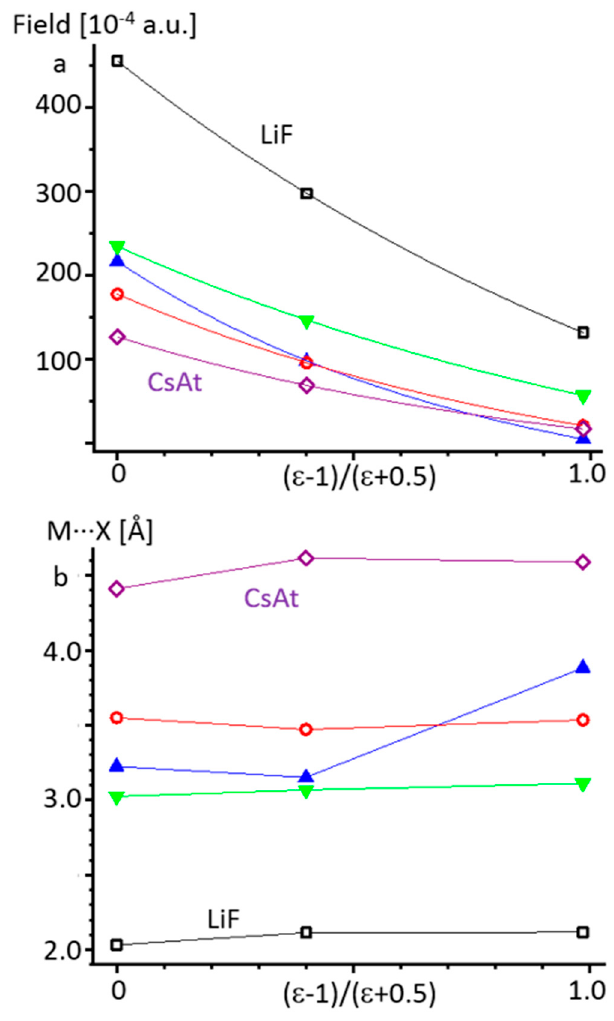
Figure 5. The limiting values of the external electric field ( a ) and the alkali metal ··· halogen distances ( b ) before the dissociation of LiF (empty black squares), KBr (empty red circles), CsAt (empty lilac diamonds), LiAt (blue upward-pointing triangles), and CsF (green downward-pointing triangles) as a function of ( ε − 1)/( ε + 0.5) under the gas-phase ( ε = 1) and PCM ( ε = 2 and 100) approximations. Lines are provided as a guide for the reader’s eyes.